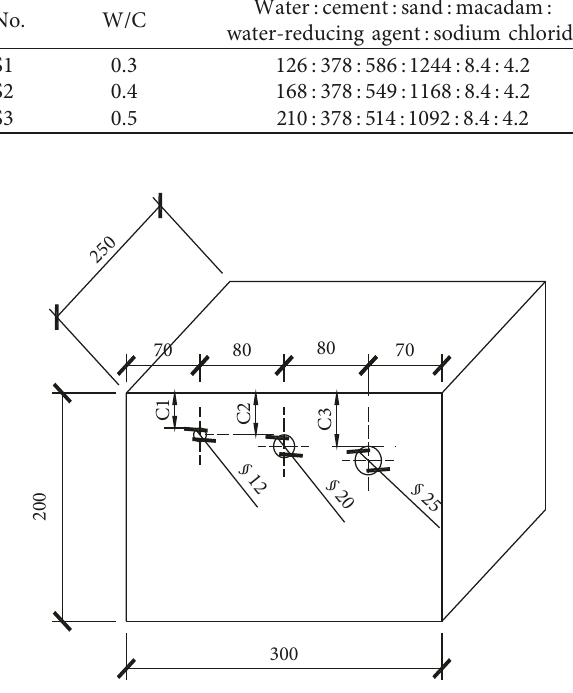
Figure 3: Size of the specimen (unit: